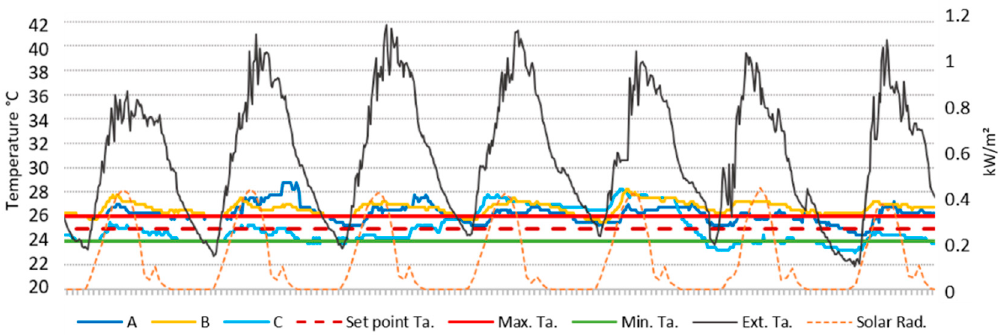
Figure 4. Monitored data collected for rooms during the selected week, June 22nd to 28th.